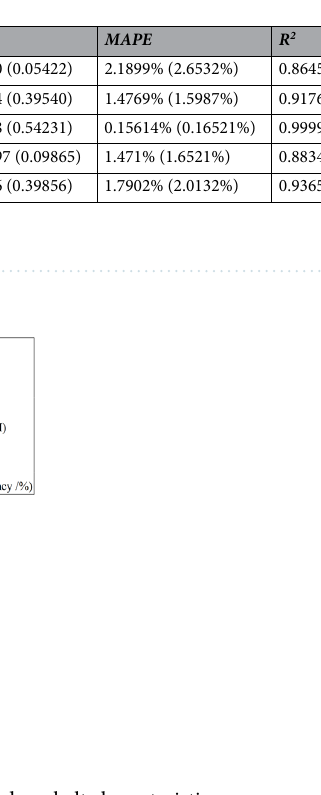
Figure 9. Abnormal analysis of control parameter values and ore belt